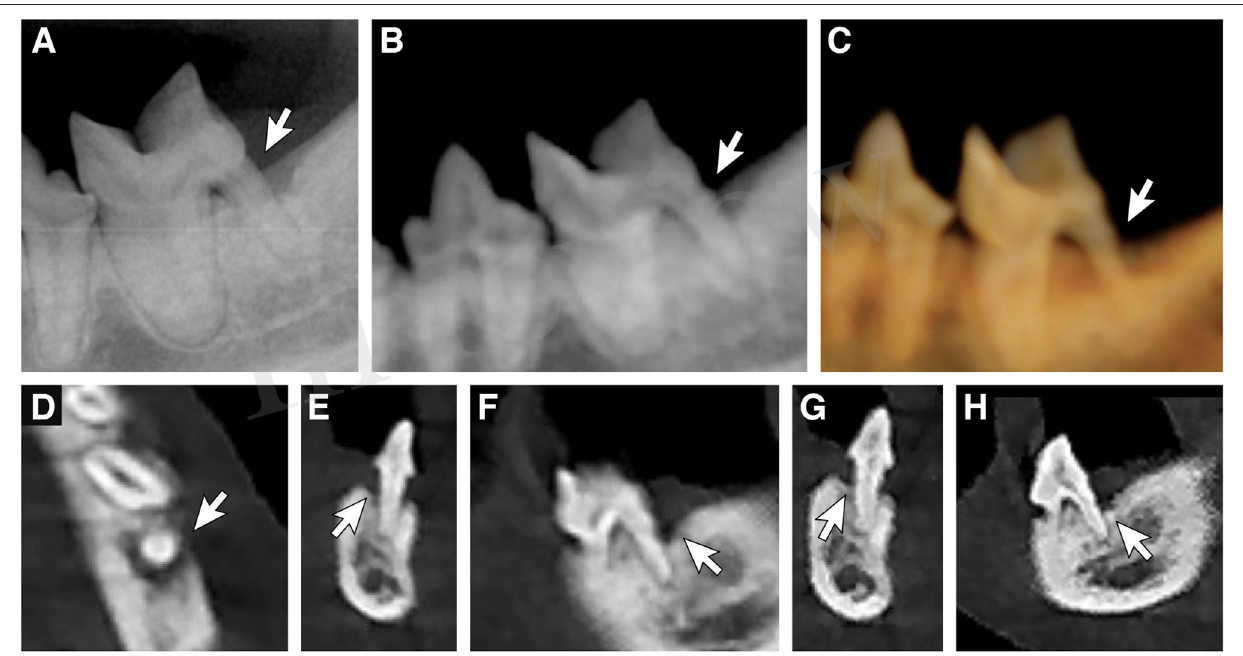
FIGURE 4 | Periodontitis . Evaluation of horizontal and vertical bone loss affecting the distal aspect of the left mandibular first molar tooth by way of (A) a dental radiograph obtained with the intraoral, parallel radiographic technique, (B) the reconstructed panoramic CBCT viewing method, (C) tridimensional rendering CBCT viewing method in tooth mode, (D) axial section multiplanar reconstruction showing mid-body of the distal root, (E) coronal section multiplanar reconstruction of the distal root, (F) sagittal section multiplanar reconstruction of the distal root, (G,H) custom cross-section multiplanar reconstructions of the distal